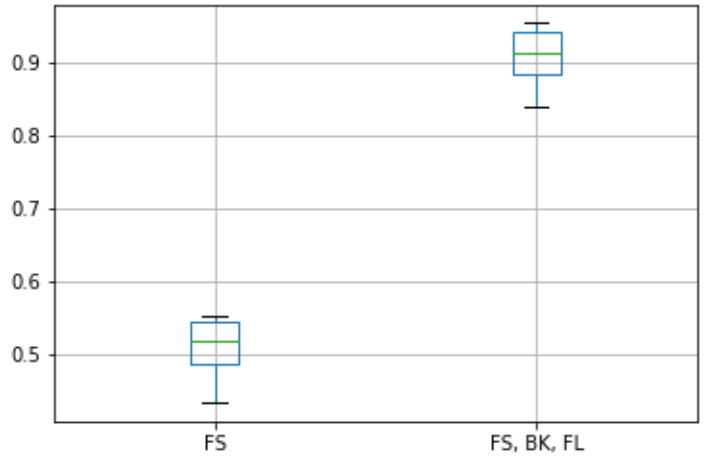
Figure 15. F1 score of the original LSTM model integrating the three OSN platforms and the alternative version considering only FS as OSN data.